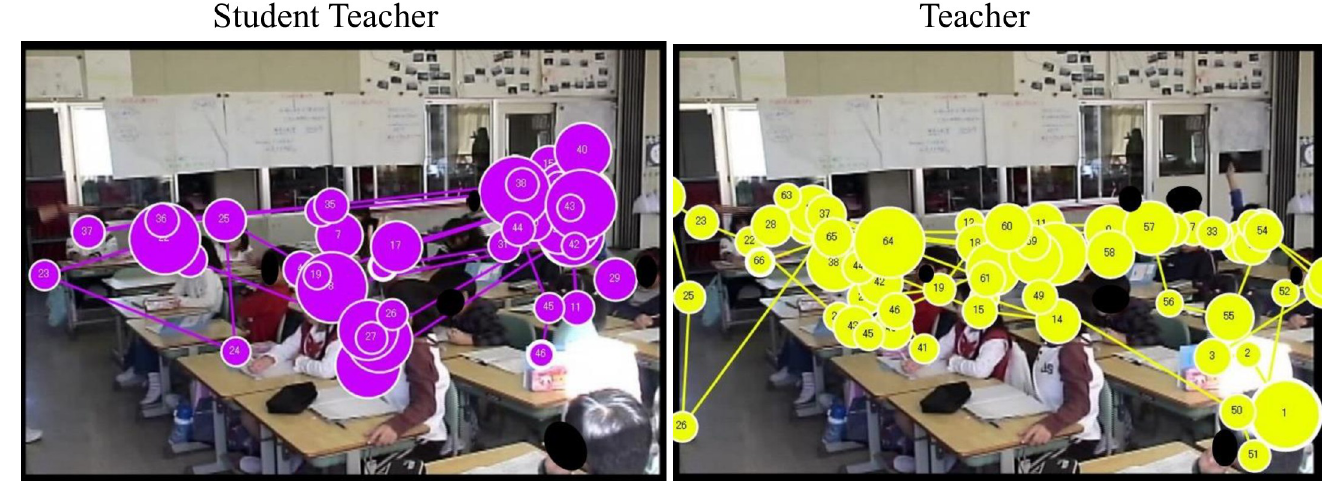
Fig 1. Examples of the participants’ gazes. Left indicates that of a teacher; right indicates that of a student teacher.